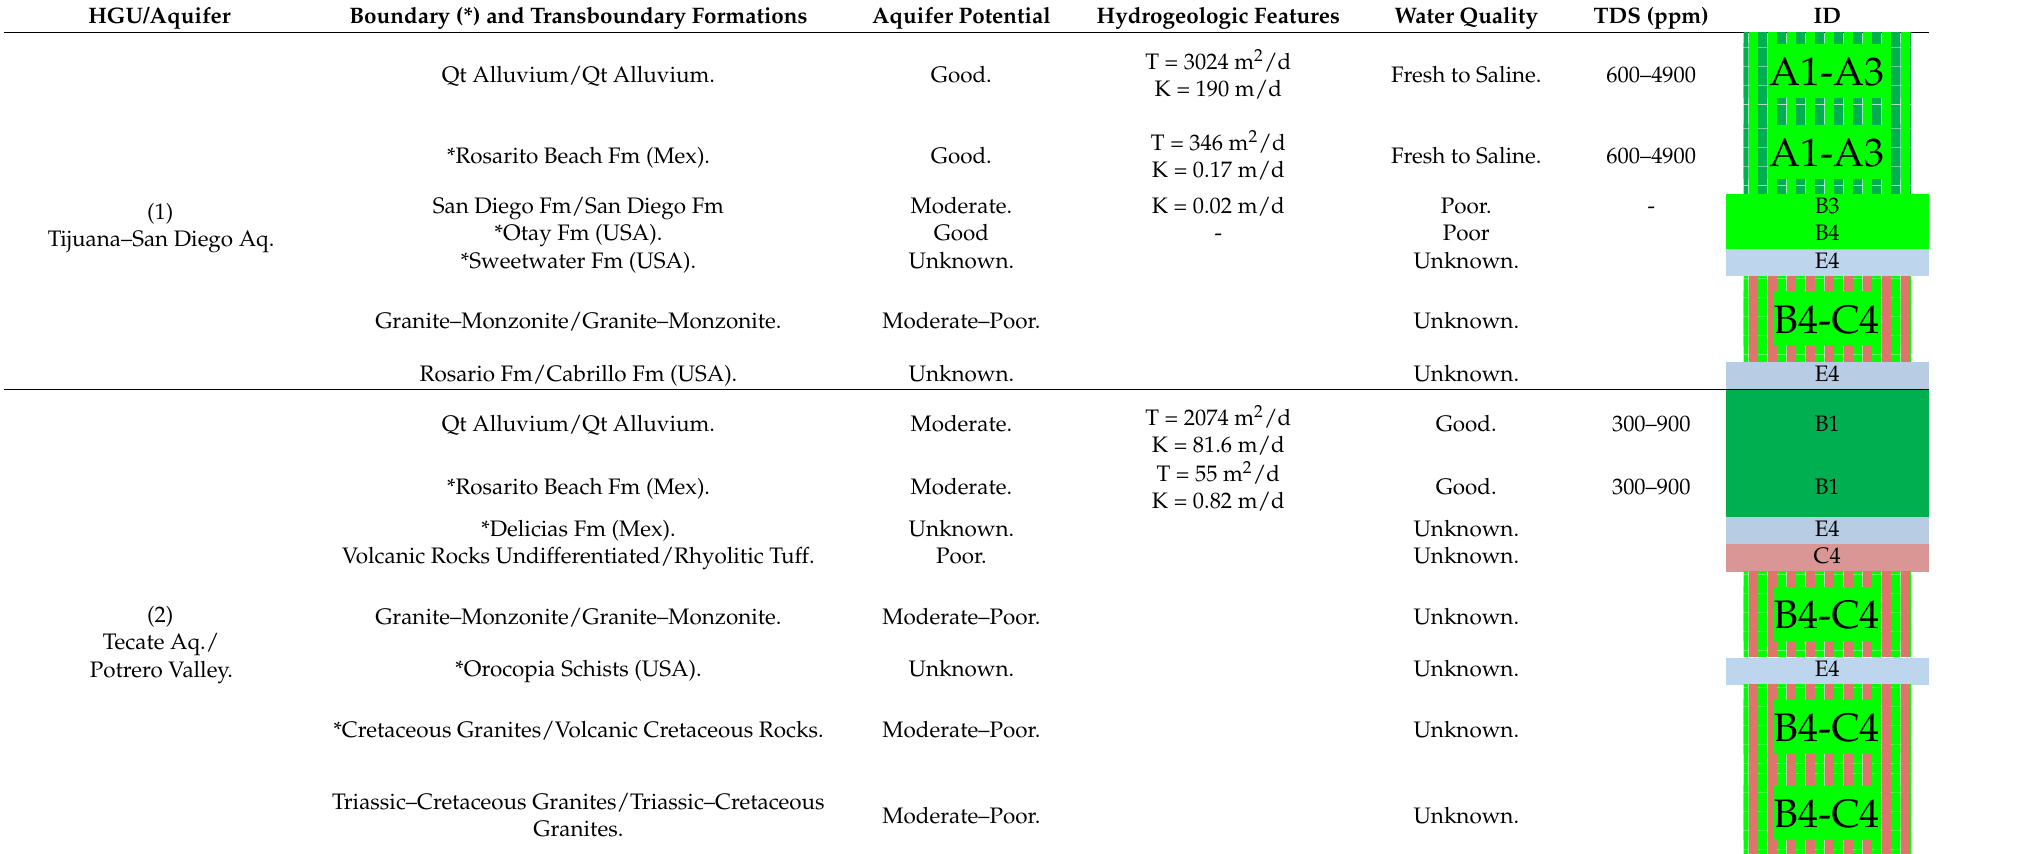
Table 3. Classification of geological formations (within their corresponding HGU) in the border region between California, Arizona, and New Mexico, U.S., and Baja California, Sonora, and Chihuahua, Mexico, according to aquifer potential and water quality (*T = Transmissivity m 2 /d, K = Hydraulic conductivity m/d, n = porosity %). The colors represent the differences among geological units. It is based on Table